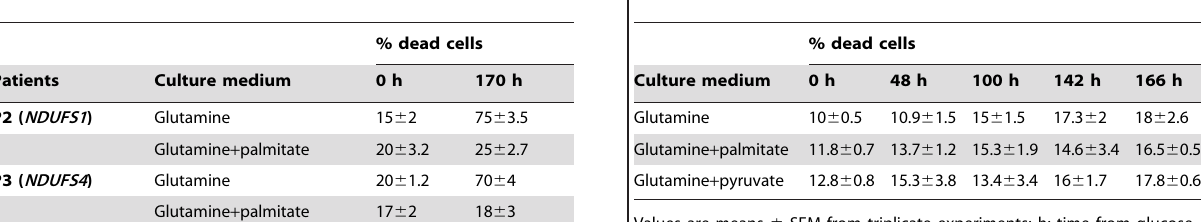
Table 3. Absence of cell death in control (Ctrl) cells after glucose withdrawal, palmitate or pyruvate supplementation.